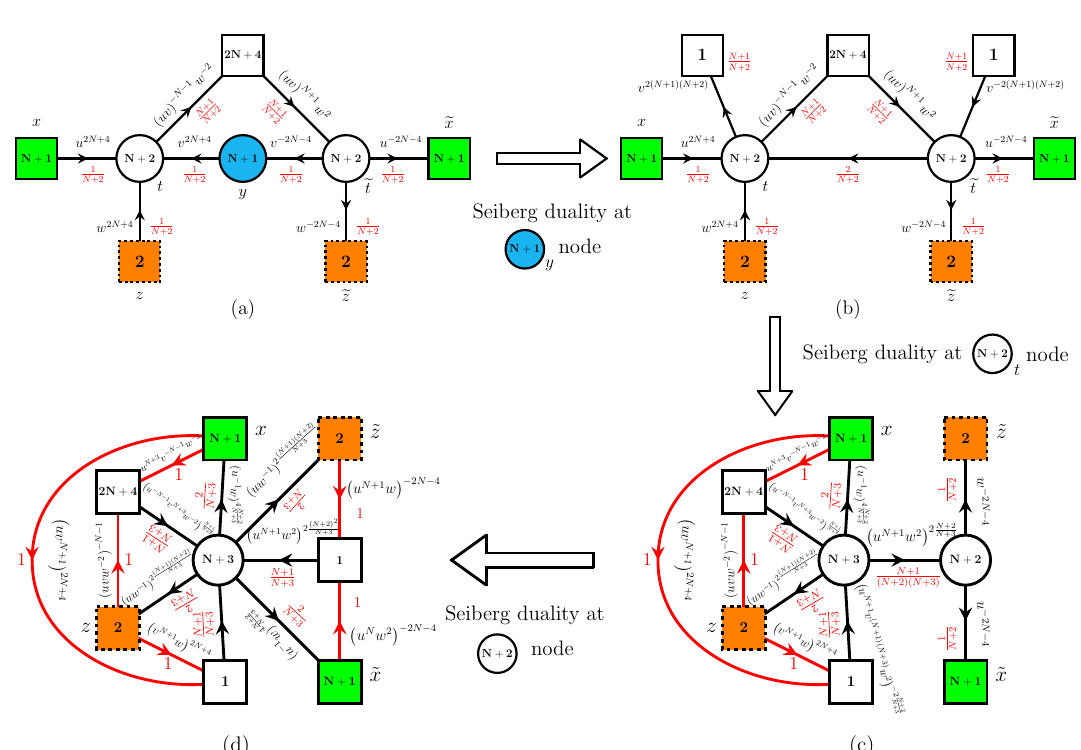
Figure 16: Chain of duality transformations of the four-punctured sphere theory. As a starting point we use two S glued A conttributions of theflip